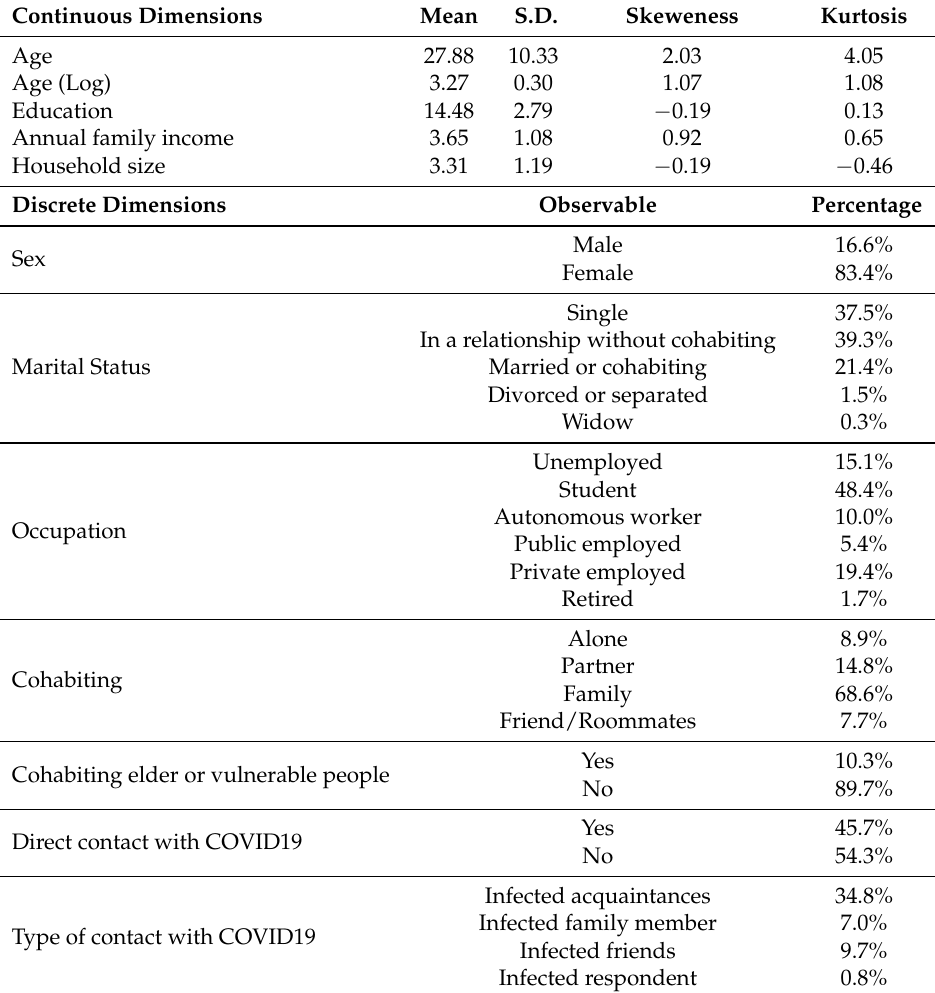
Table 1. Socio-demographic characteristics and experiences with